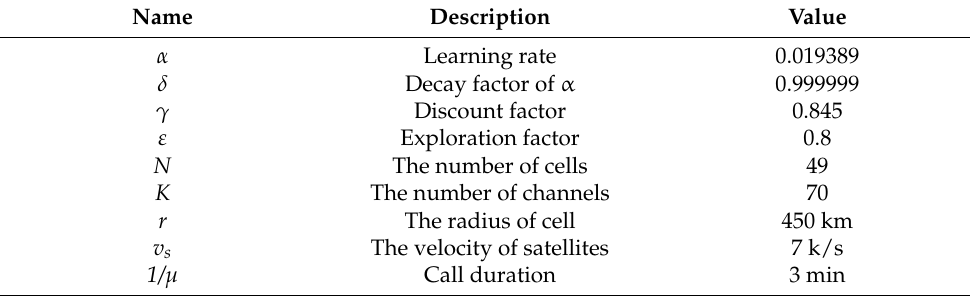
Table 1. Parameter settings of the